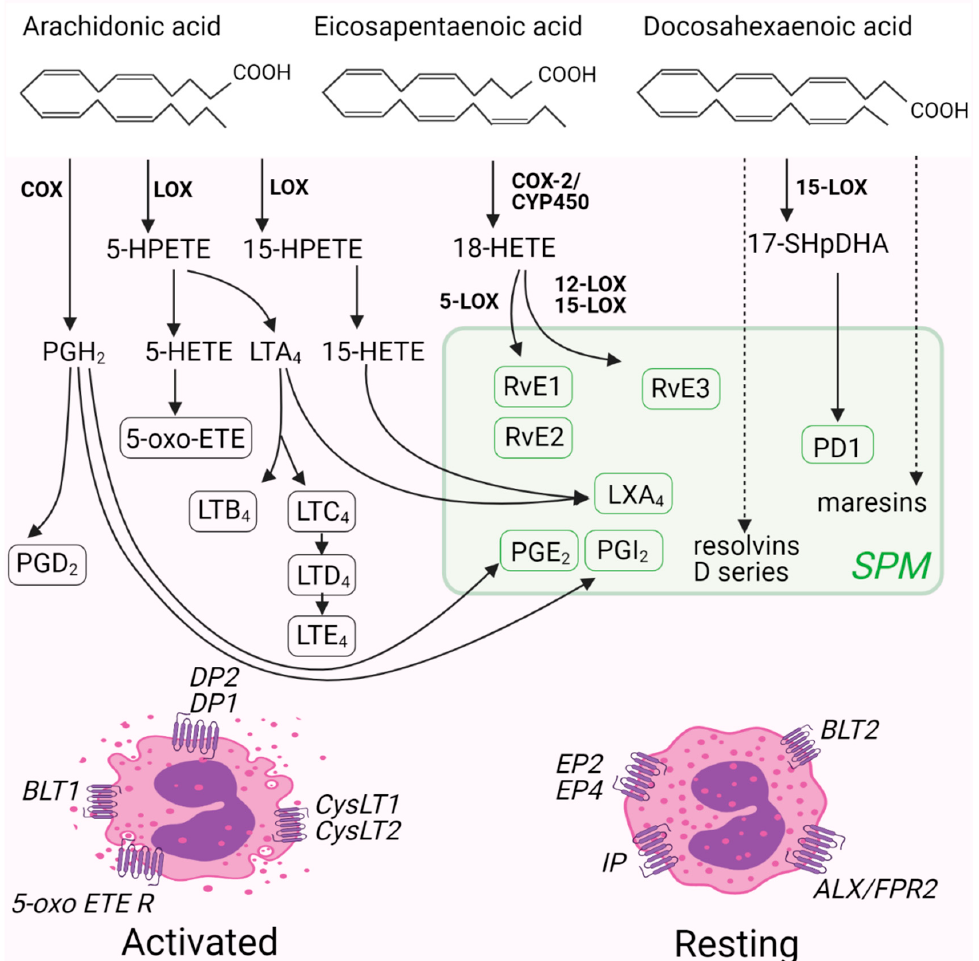
Figure 2. A schematic representation of PUVA metabolism into bioactive lipid mediators. PUVA are converted into bioactive lipid mediators capable of potentiating or inhibiting eosinophil activation via their specific G protein-coupled receptors. Abbreviations: 5-oxo-ETE, 5-oxo-eicosatetraenoic acid; 5-oxo-ETE R, 5-oxo-eicosatetraenoic acid receptor; ALX/FPR2, lipoxin A4 receptor/formyl peptide receptor 2; BLT 1 or 2, leukotriene B4 receptor 1 or 2; COX, cyclooxygenase; CYP450, cytochrome P450; CysLT1 or 2, cysteinyl leukotriene receptor 1 or 2; DP1 or 2, prostaglandin D2 receptor 1 or 2; EP2 or 4; prostaglandin E2 receptor 2 or 4; HETE, hydroxyeicosatetraenoic acid, HPETE, hydroperoxyeicosatetraenoic